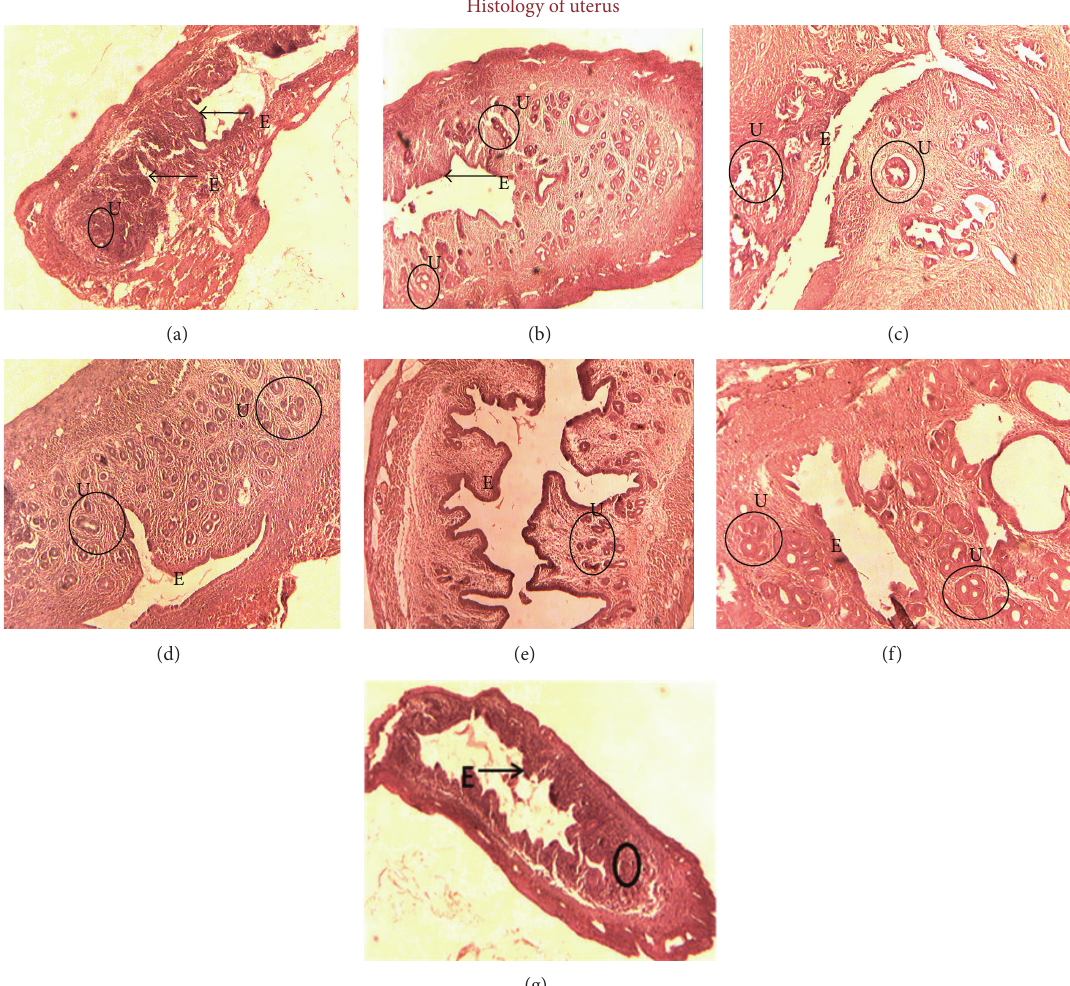
Figure 3: Histological study of the uterus after the ovariectomy and EAME treatment. Ovariectomised mice were orally administered with EAME for 30 days. The uterus was removed after the termination of administration of the extract. The uterus was formalin-fixed, dehydrated in alcohol, fixed in paraffin, and Hematoxylin and Eosin stained (magnification 10x). (a) OVX control, (b) Sham control, (c) estradiol treated group, (d) EAME 200 mg/kg, (e) EAME 100mg/kg, (f) EAME 50 mg/kg, and (g) EAME 25 mg/kg. “U” (circled) indicates uterine glands; “E” indicates uterine